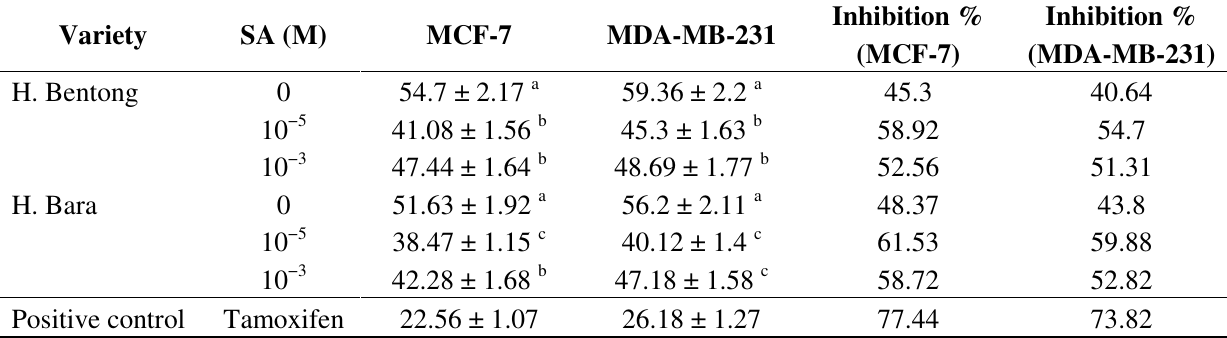
Table 3. Anticancer activities (cell viability) and percent of inhibition of ginger extracts towards MCF-7 and MDA-MB-231 cell lines as determined by the MTT assay (at concentration 37.5 µg mL −1 ).